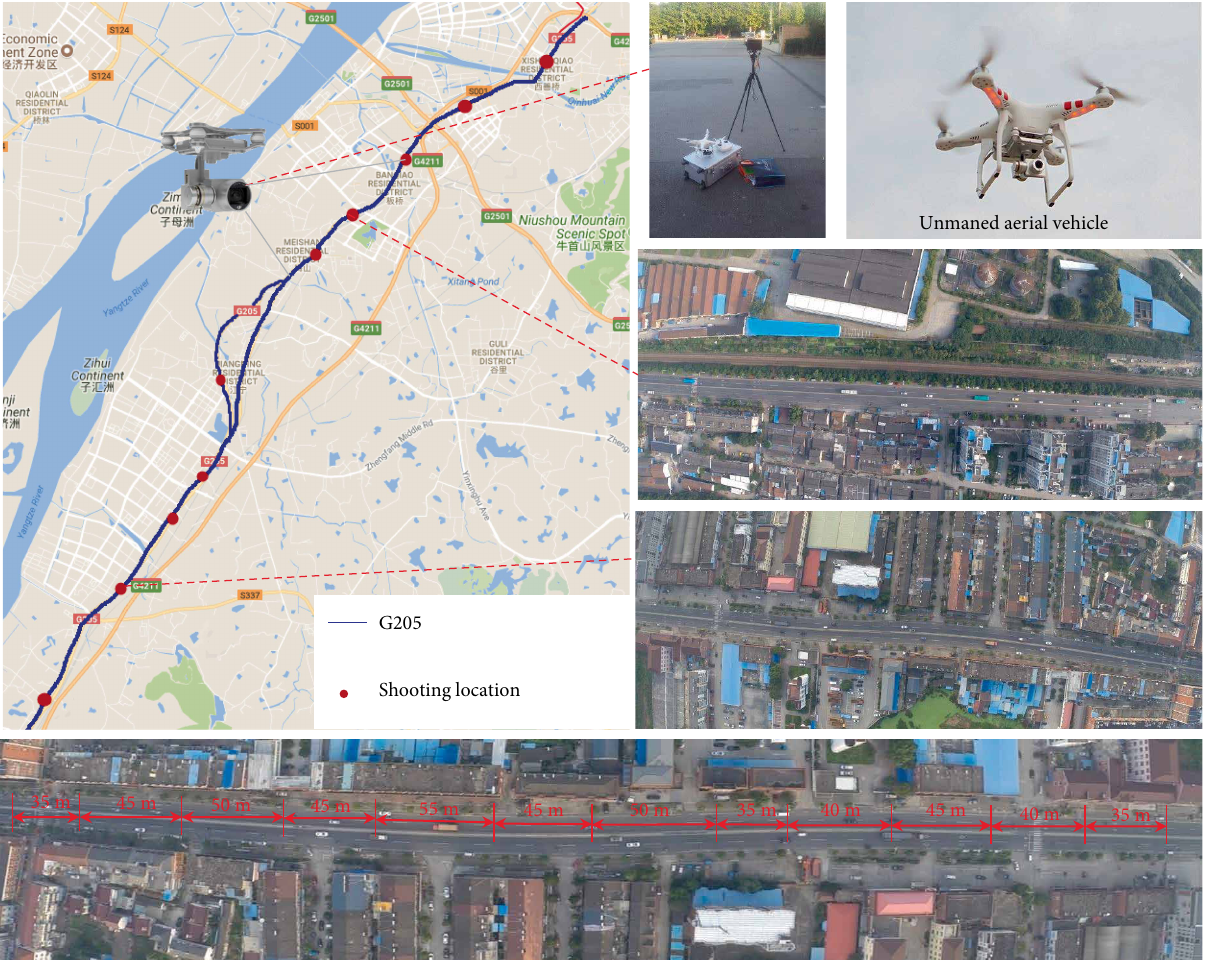
Figure 1: Scheme of shooting location and data collection.